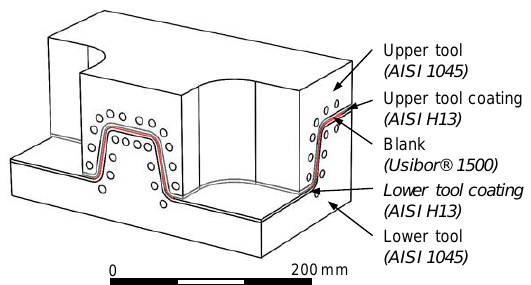
Figure 3. Simulated geometry of the bimetallic hot stamping tool.